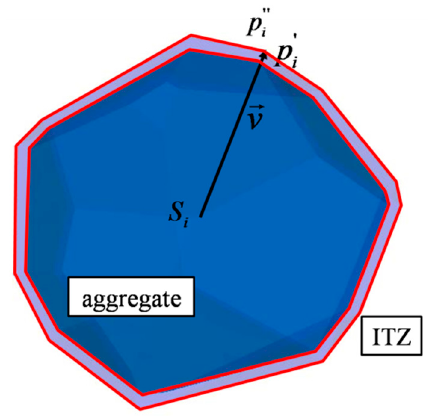
Figure 6. Schematic diagram of generating the Interfacial Transitional Zone (ITZ).